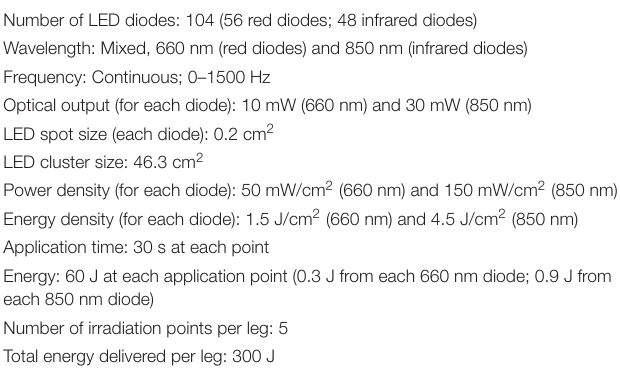
TABLE 3 | Parameters of photobiomodulation. Number of LED diodes: 104 (56 red diodes; 48 infrared